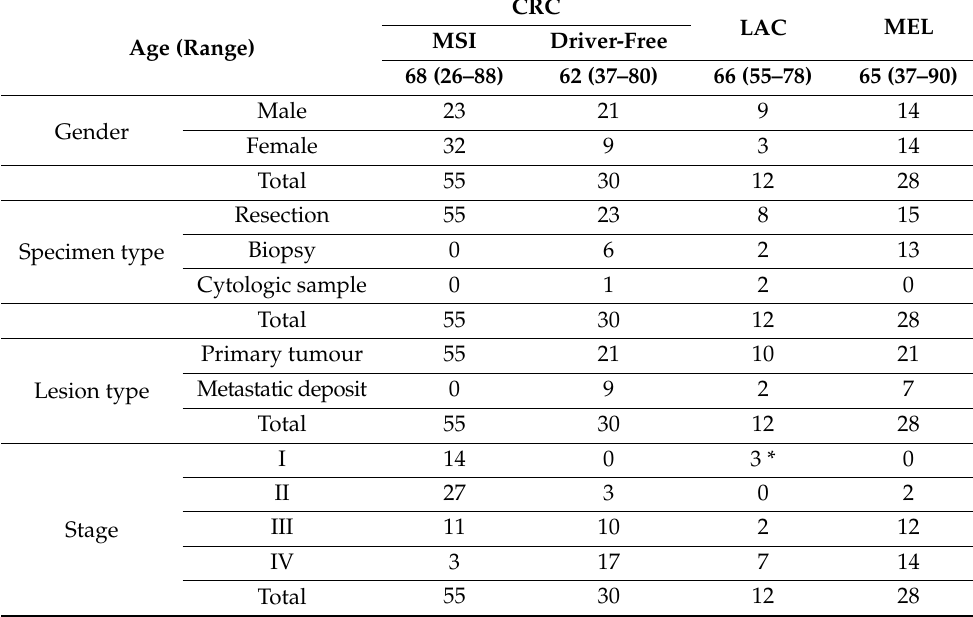
Table 1. Clinico-pathological features of the patient